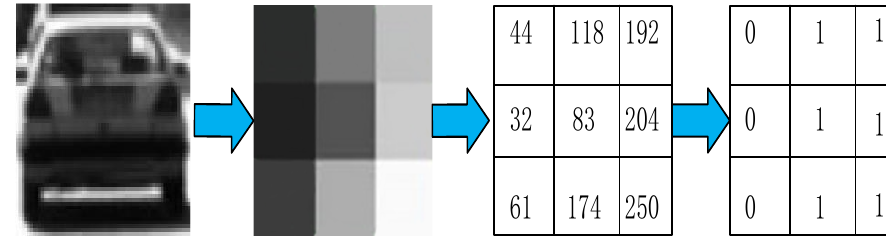
Figure 5. Local binary pattern diagram.